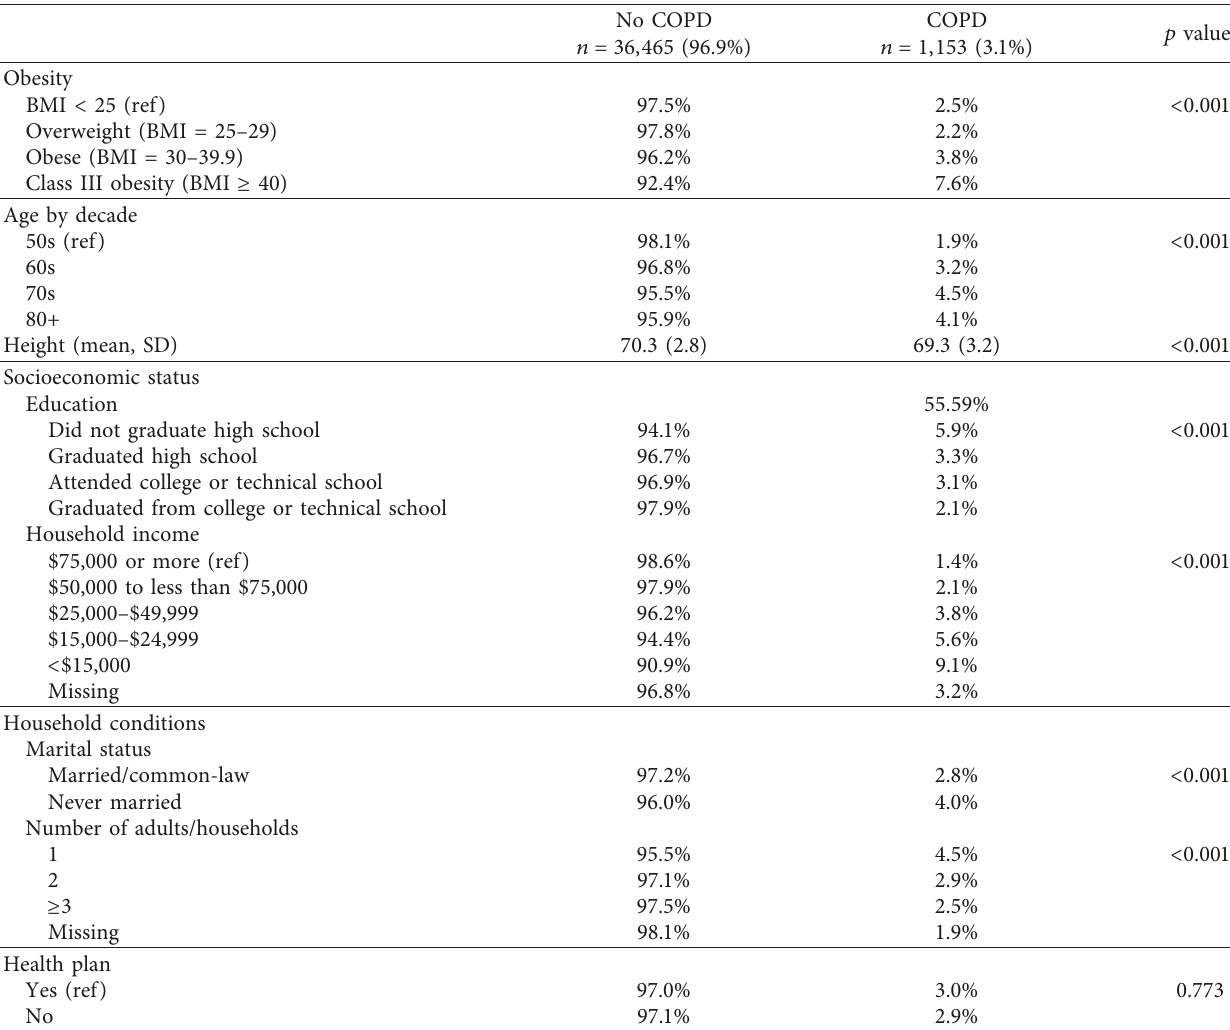
Table 3: Prevalence of COPD by obesity level and other characteristics among non-Hispanic white older men (aged 50+) who had never smoked ( n � 37 , 618) 1